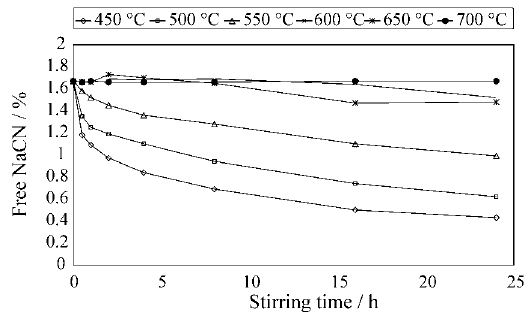
Fig ure 9. Free cy a nide in the leach ing tests us ing prod ucts roasted at dif fer ent tem per a tures for 1 h; 1.67% NaCN ini tial con cen tra tion, 1:3 solid:liq uid ra tio. Ta ble 5. NaCN con sump tion in cyanidation of the roasted prod ucts. Roast. tem per